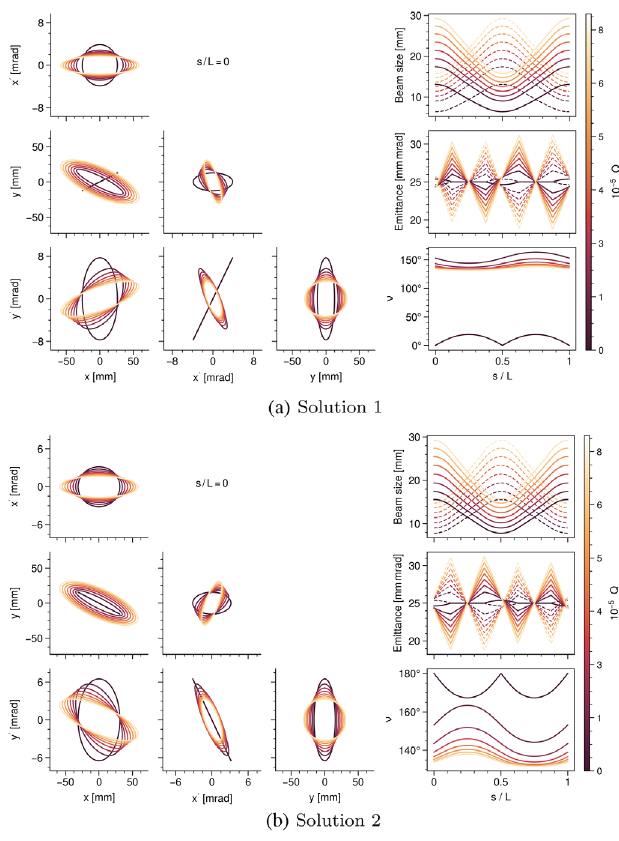
FIG. 10. Matched solution in a coupled FODO lattice as space charge is increased with (a) ε 2 ¼ 0 and (b) ε 1 ¼ 0 . The lattice is coupled due to skew quadrupoles. Left: phase space projections at the lattice entrance. Right: beam parameters within the lattice. Solid lines are for x and dashed lines are for y in the top two